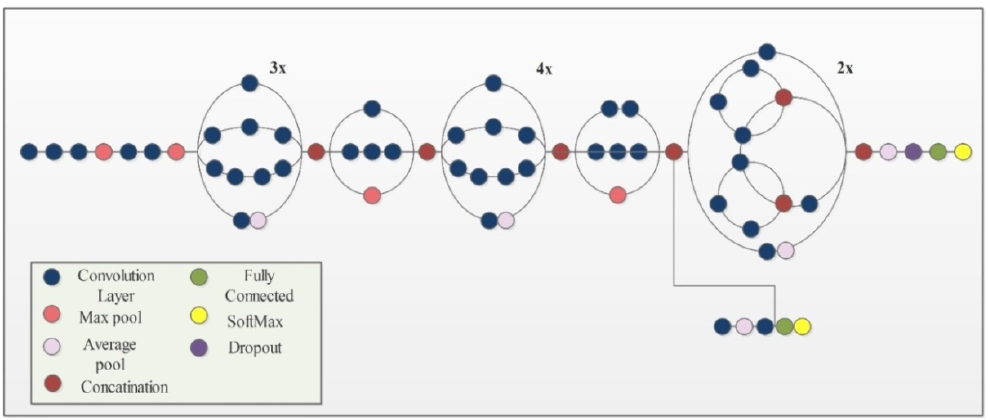
Figure 4. Network architecture of Inceptionv3 model.